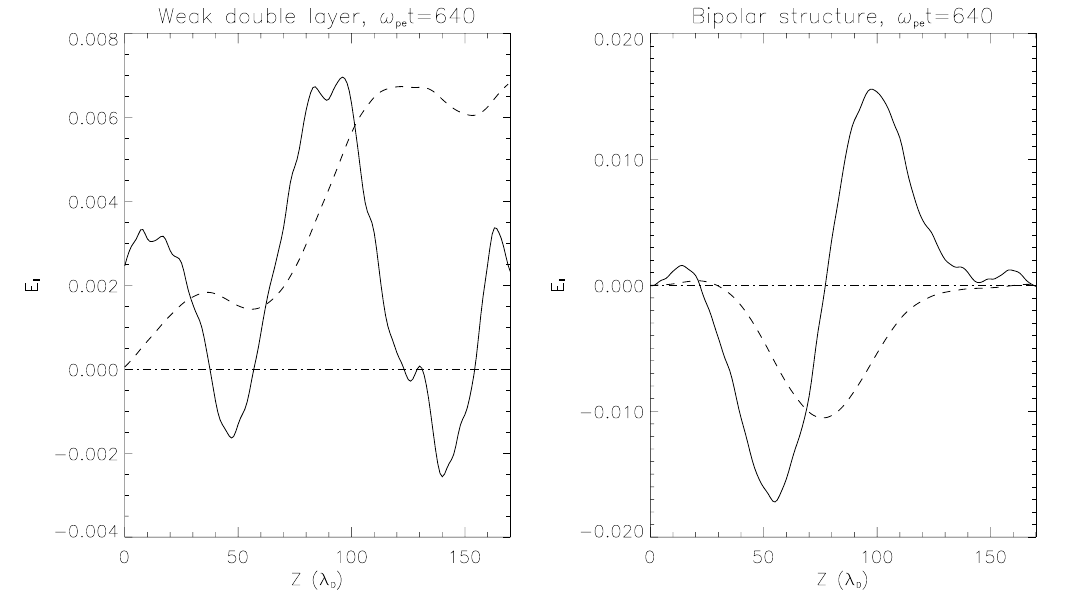
Fig. 7. Two different electric field structures at the same time (solid line). The spatial extension along the magnetic field is similar. The dashed line on both plots is proportional to the integrated electric field, i.e. the electric potential: it is non-null for the weak double layer (left panel), whereas it is zero for the symmetric bipolar structure (right